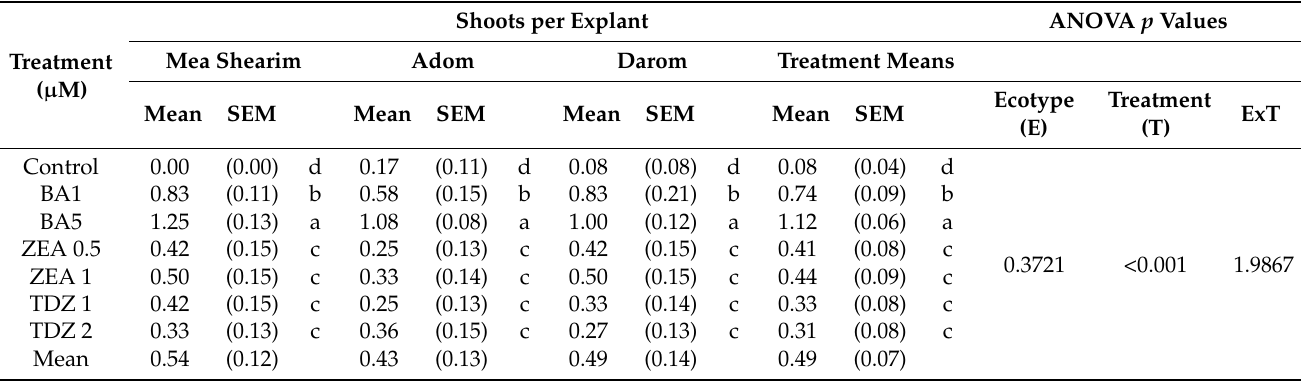
Table 1. Multiplication rate (MR) of three S. acmophylla ecotypes. Data are mean number of proliferat- ing axillary shoots recorded after PGR treatment and subsequent growth on AC-containing